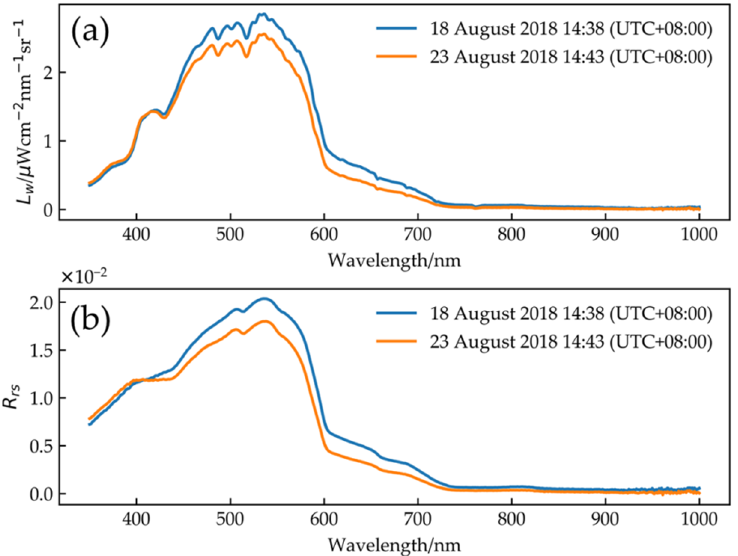
Figure 6. ( a ) Water-leaving radiance; ( b ) remote sensing reflectance.